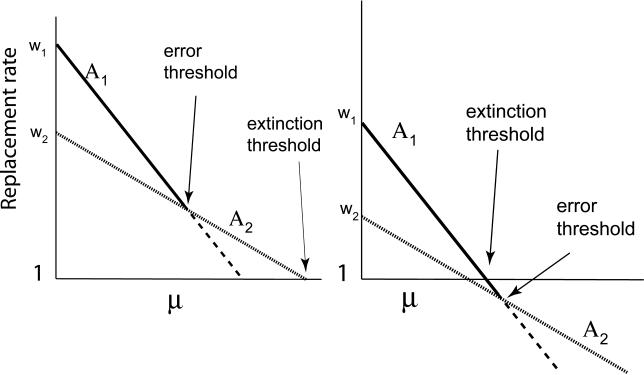
Extinction versus Error CatastropheLeft: the error threshold is crossed at a lower mutation rate (μ) than the extinction threshold.Right: the extinction threshold is crossed before the error threshold.Otherwise as in Figure 3.